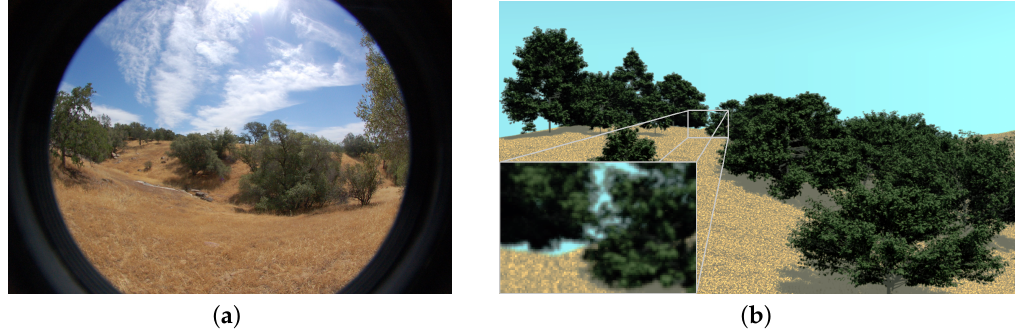
Figure 3. ( a ) plot #116 in the National Ecological Observatory Network’s (NEON) D17 Domain and ( b ) the virtual